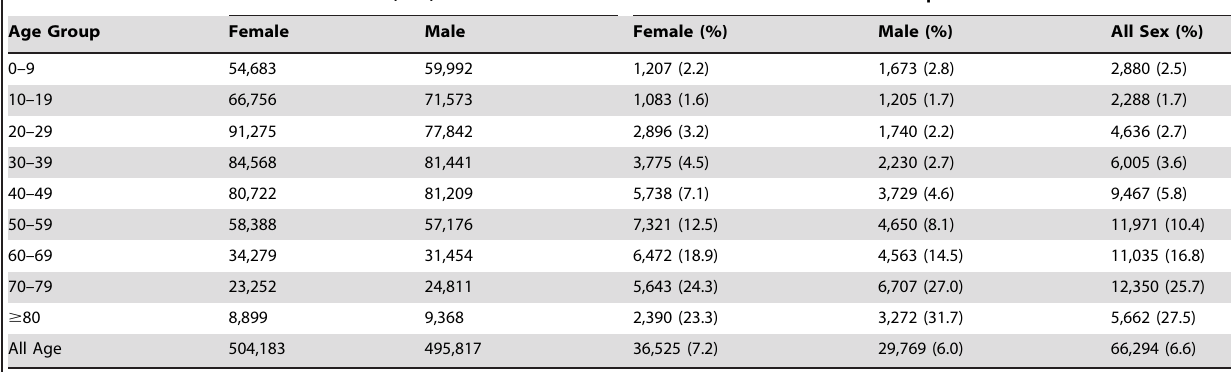
All Persons in the 1,000,000-Person Cohort Numbers of Patients With One-Stop Visits